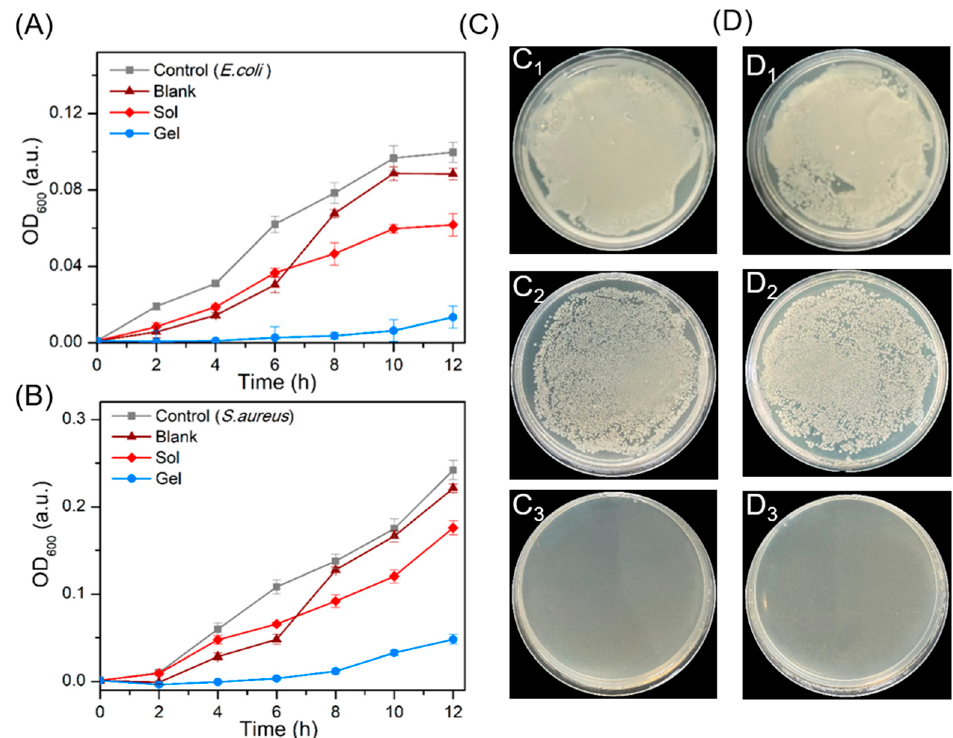
Figure 5. Time-dependent antimicrobial effects of the ZW solution and ZW/GDL hydrogel toward ( A ) E. coli and ( B ) S. aureus bacteria. ( C ) Photographs of bacterial colonies formed by E. coli treated with control ( C 1 ), solution ( C 2 ), and hydrogel ( C 3 ). ( D ) Photographs of bacterial colonies formed by S. aureus treated with control ( D 1 ), solution ( D 2 ), and hydrogel ( D 3 ). For comparison, blank refers to NAHCO 3 /GDL solution of pH 6.0 without ZW.